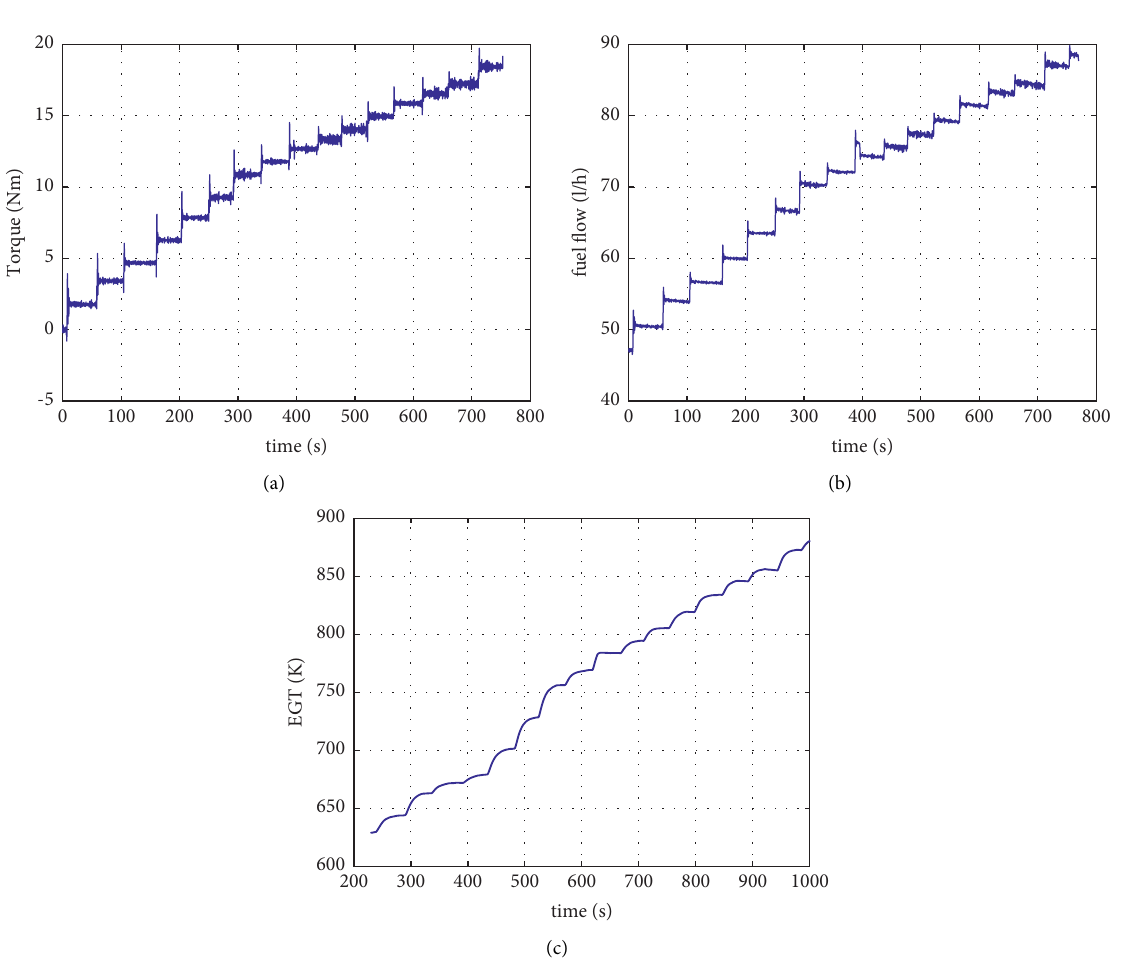
Figure 4: Engine load experimental results. (a) Torque. (b) Fuel flow. (c)